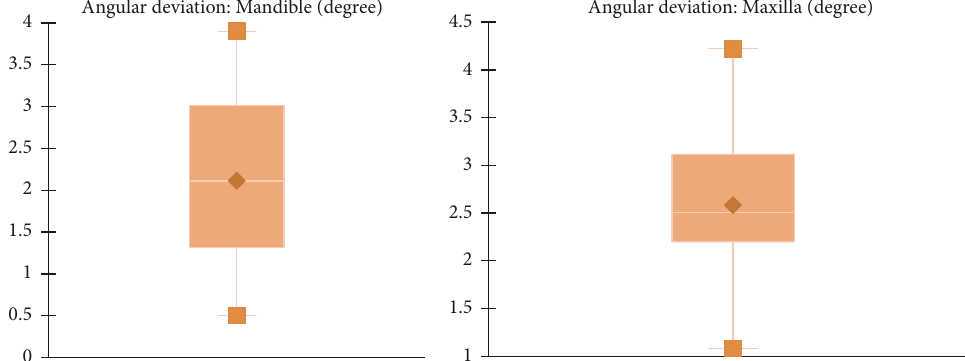
Figure 11: Mean angular deviation for implants inserted in mandible and